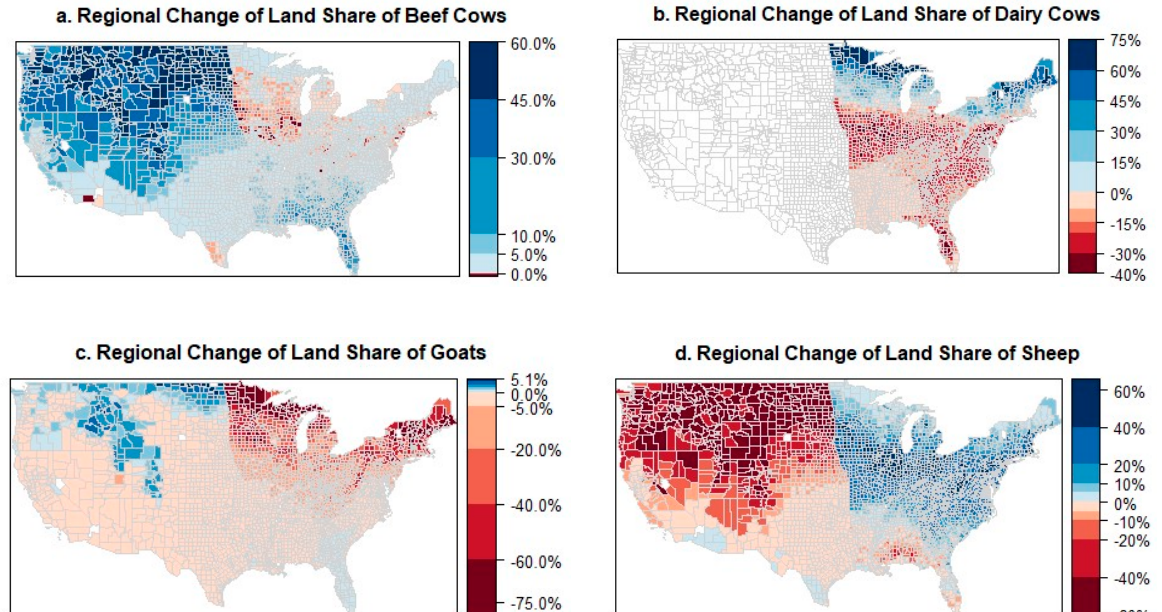
Figure 5. Projected land share change of livestock by 2090 relative to 2020 under climate scenarios.